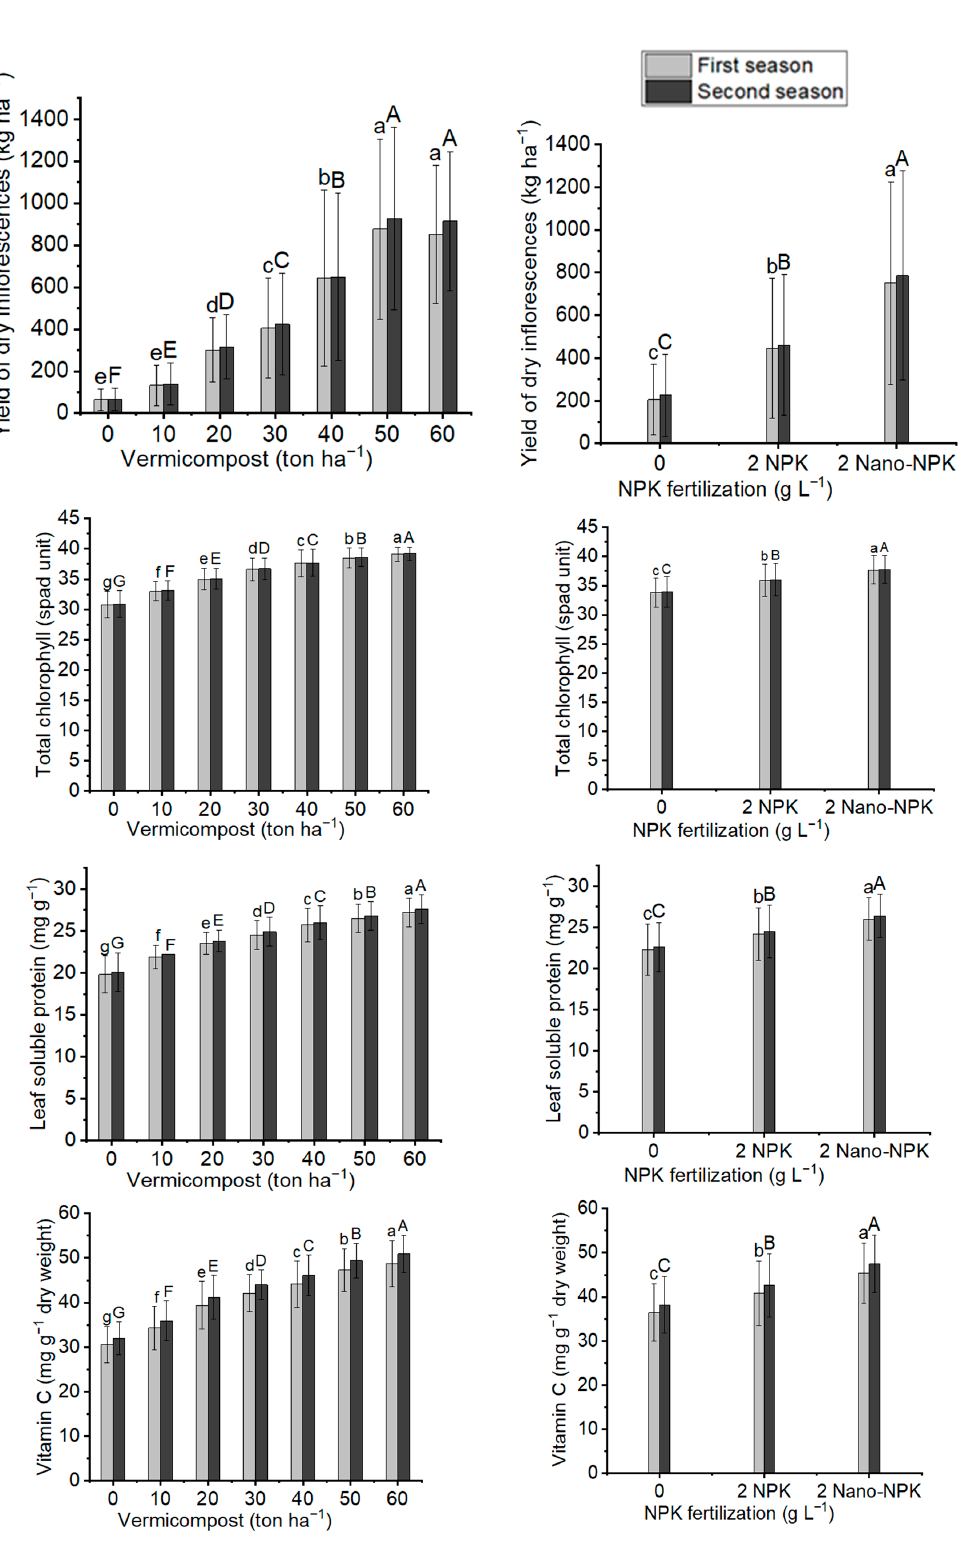
Figure 5. In both seasons of the study, the mean values of yield of dry inflorescences (kg ha − 1 ), total chlorophyll (spad unit), leaf soluble protein (mg g − 1 ), and vitamin c content (mg g − 1 dry weight) of Moringa oleifera trees as influenced by vermicompost and NPK fertilization are provided below. The data are presented as a mean with standard error ( n = 3). Bars with identical lowercase letters are not significant at the 0.05 level of probability.